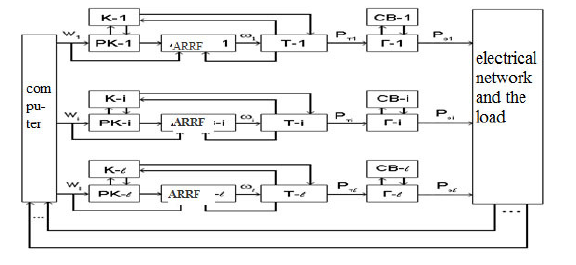
Figure 2: Block diagram of the power